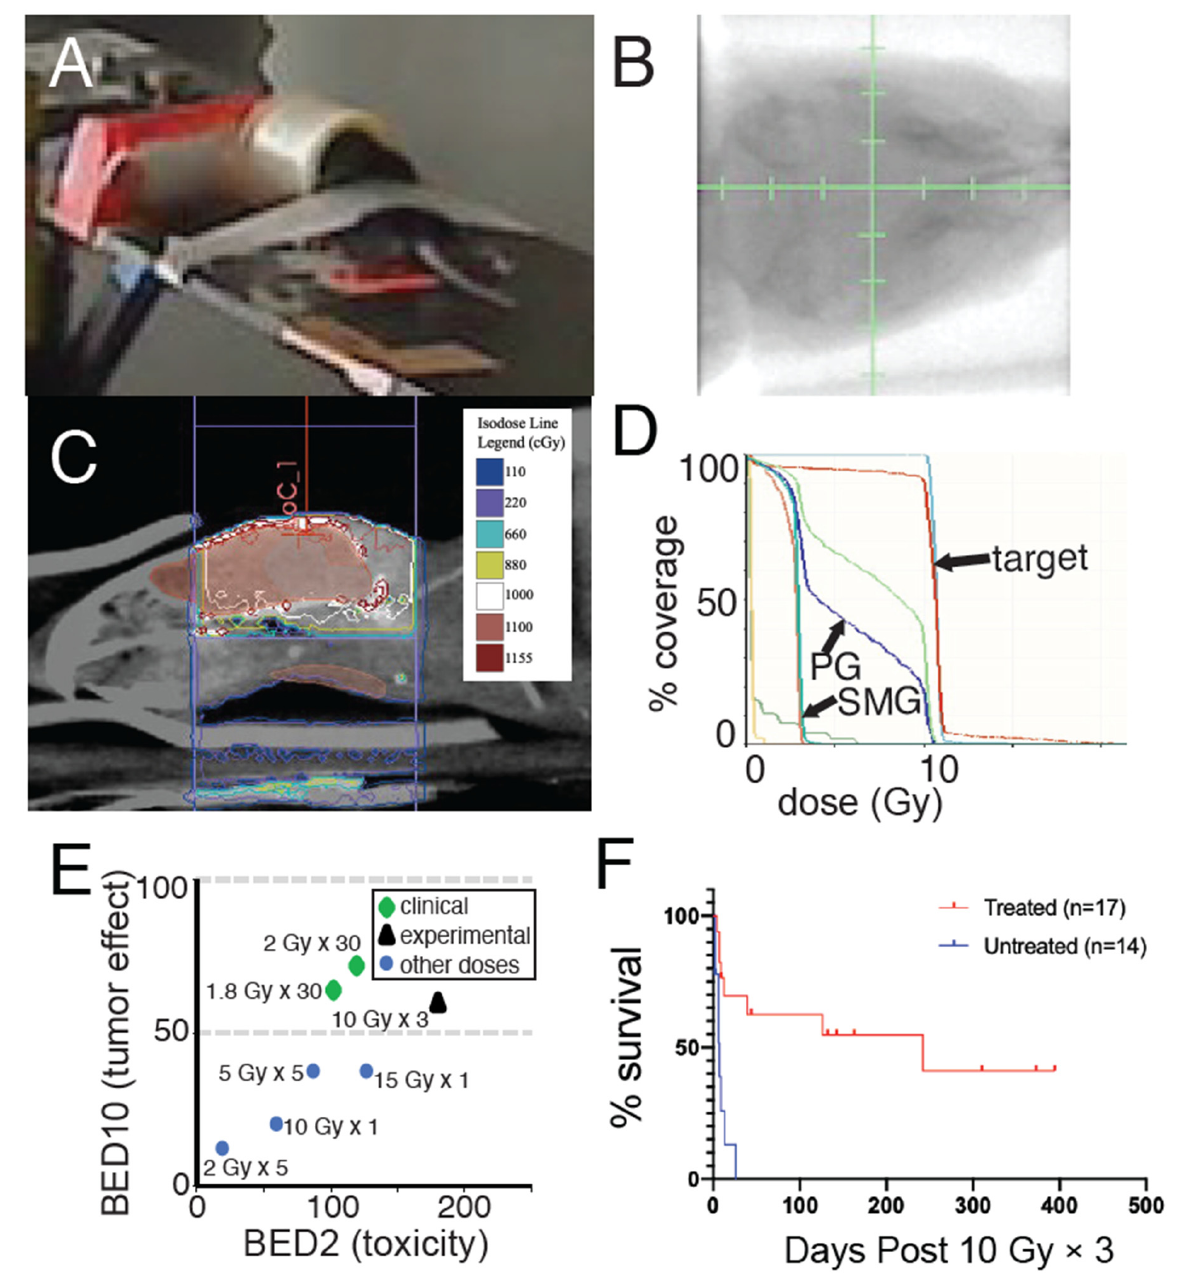
Figure 3. Volumetric characterization of radiation treatment plan for image-guided focal brainstem mouse irradiation. ( A ) Example of mouse anesthetized with isoflurane gas on the irradiator couch. ( B ) kV image guidance prior to radiation therapy. ( C ) Sagittal image from a cone-beam CT with isodose lines showing lateral beams targeting brainstem. ( D ) Dose-volume histogram demonstrates >95% of brainstem target is covered by radiation dose prescription with minimal radiation dose to the parotid and submandibular glands (PG, SMG). ( E ) Biologically effective dose (BED) calculations identify 10 Gy × 3 = 30 Gy ( ) as biologically similar to the standard-of-care for DMG of 1.8 Gy × 30 = 54 Gy ( ) compared to other fractionation schemes ( ). BED10 is shown on the y-axis to model effective dose to rapidly dividing tissues, such as tumors. BED2 is shown on the x-axis to model effective doses for slowly dividing normal tissues, such as normal brain tissue, estimated to have a low α / β ratio of two. ( F ) Survival of nPtenA FL/+ mice with tumors lacking PTEN but retaining ATM treated with or without 10 Gy × 3. p < 0.001, log-rank